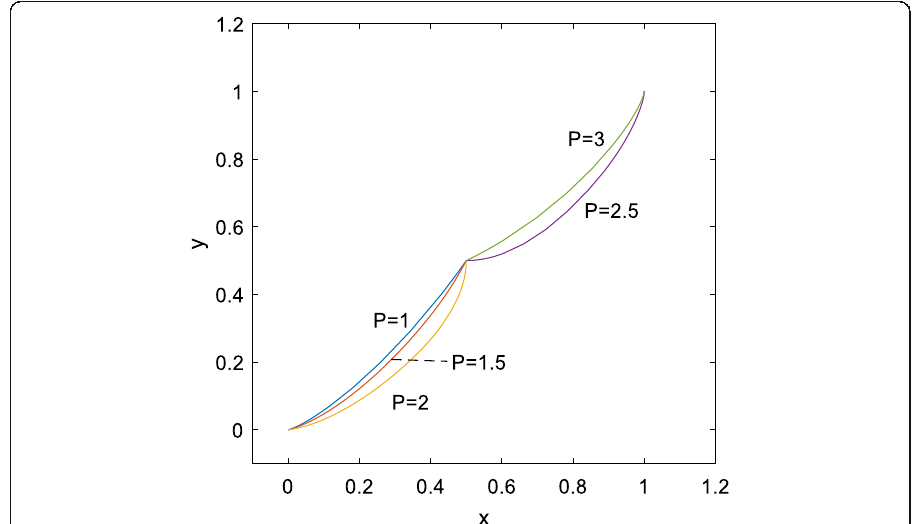
Fig. 11 Evolutionary game of the system with different penalties. Source: Authors ’ processing using